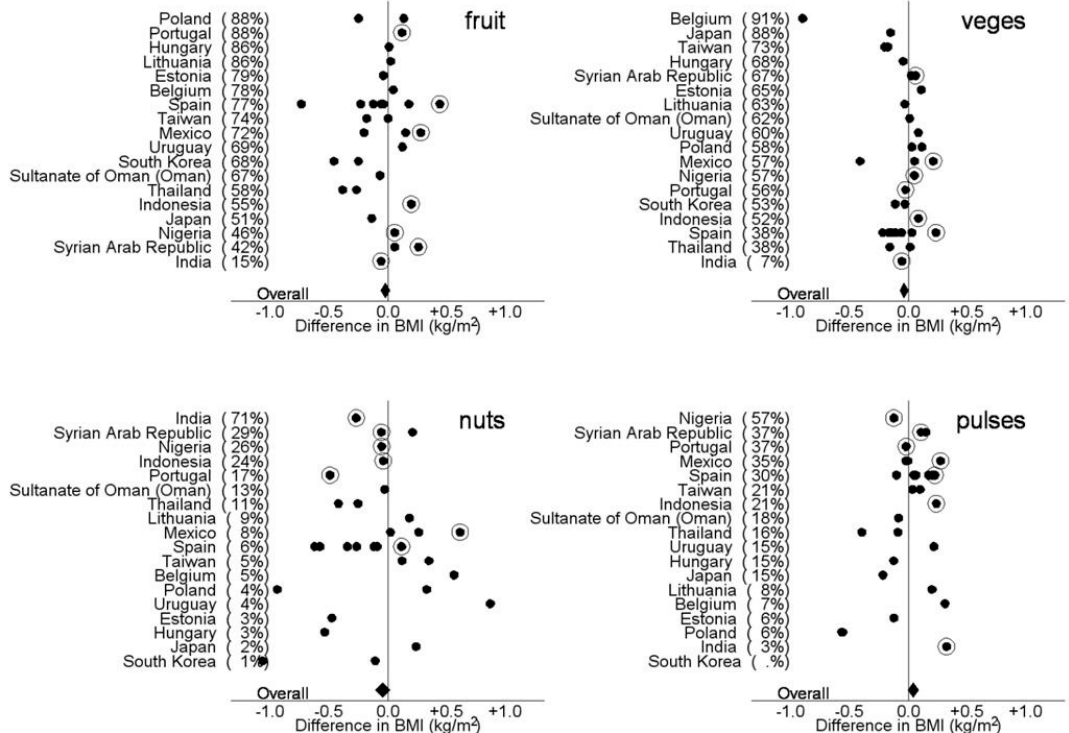
Figure 4. Differences in BMI (kg/m 2 ) between children who reported eating fruit, vegetables, pulses, and nuts three or more times per week and those who reported eating fruit, vegetables, pulses and nuts 1 to 2 times per week or never in each centre after controlling for country GNI, age, sex, measurement type (reported or measured). The solid diamond represents the overall effect. The proportion of participants who reported eating fruit, vegetable, pulses and nuts three or more times per week is shown in parentheses after each country. The solid dots represent centres with reported heights and weights and the circled dots represent centres that measured heights and weights. Table 1. BMI i difference relative to the never use category for reported dietary intake of fruit, vegetables, pulses and nuts and BMI of study participants (+/ − kg/m 2 , (SE)). Use Three or More Use Once or Twice per Week